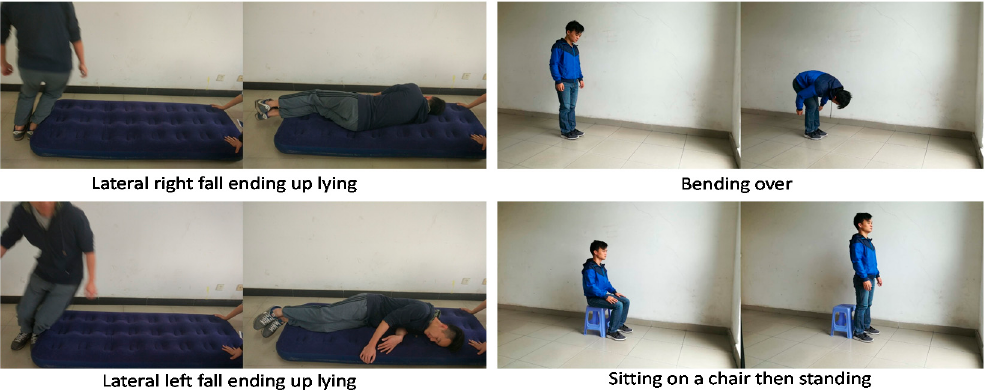
Figure 8. Conducting falling and ADL.